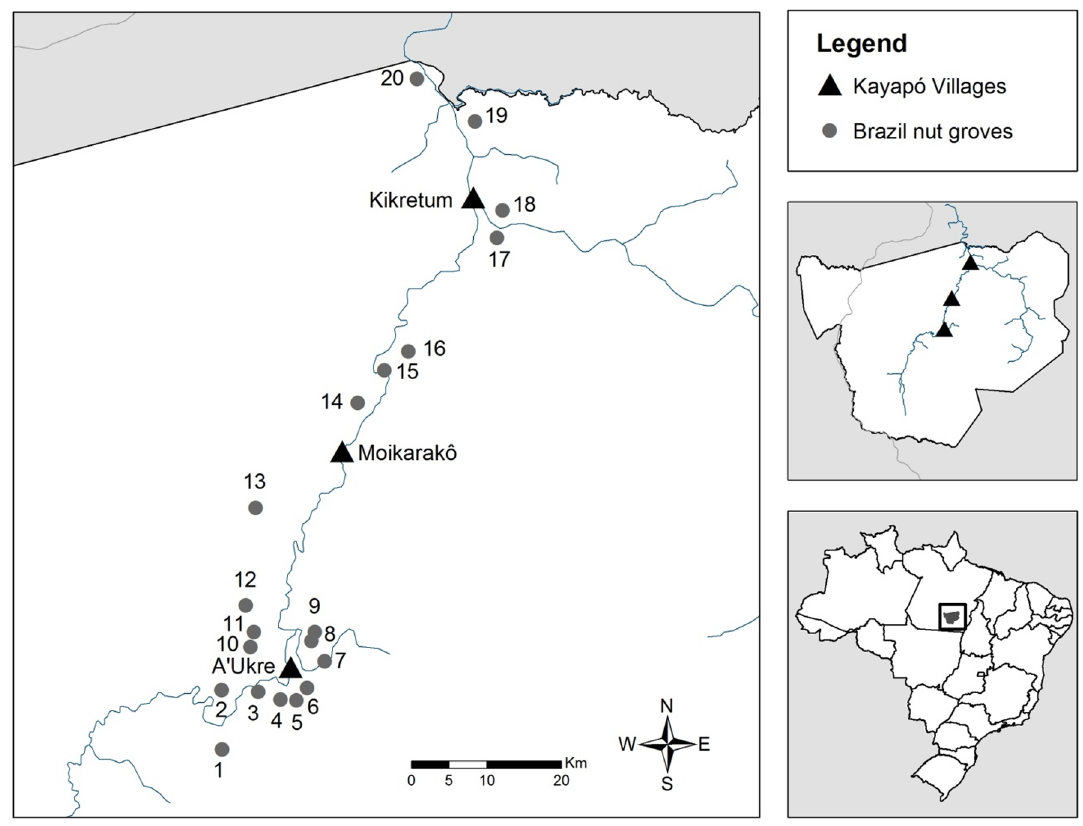
Figure 1. Map of the study site. The triangles indicate the location of the three Kayapo´ villages and the points, the location of the 20 B. excelsa groves sampled in this study, in Kayapo´ Indigenous Land, southeastern Amazonia. Identification numbers of groves correspond to those of Table S1 in the supporting information.